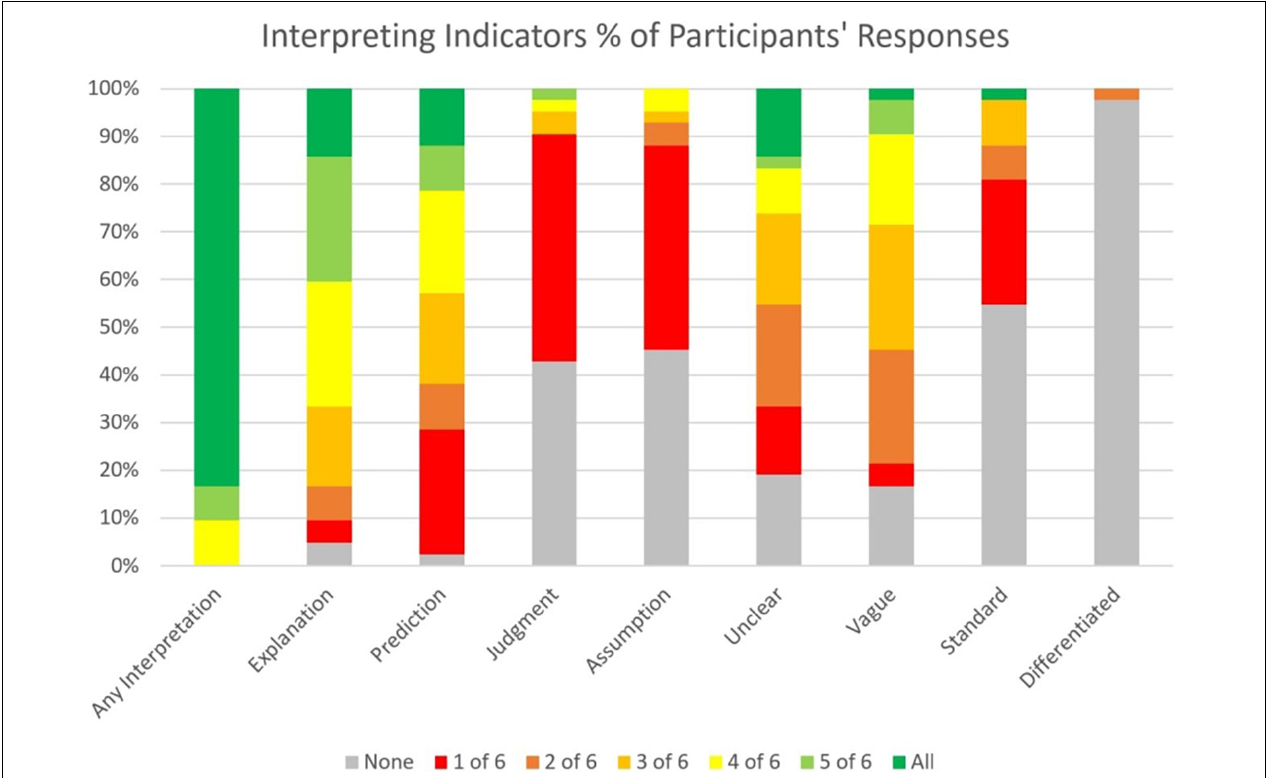
FIGURE 5 | Proportion of interpreting indicators within participants’ responses. Teacher students’ made a total of six different video analyses. The Figure shows the proportion of each interpreting indicator present across all six interpretations of each participant. Response proportions are depicted with a red-yellow-green color scale to represent fewer to more presence of an indicator across participants’ six responses. Indicator bars demonstrate the distribution of these proportions across all participants. Results based on 240 responses from 42 participants (6 responses per participant, 12 missing